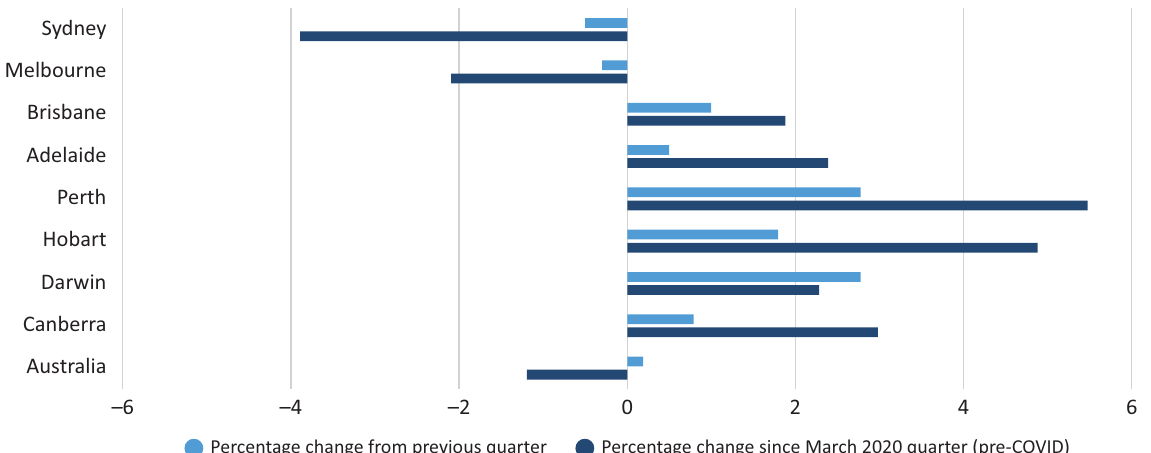
Figure 5. Percentage rental prices changes in Australian capital cities (March 2020 vs. September 2021). Source: Australian Bureau of Statistics (2021).